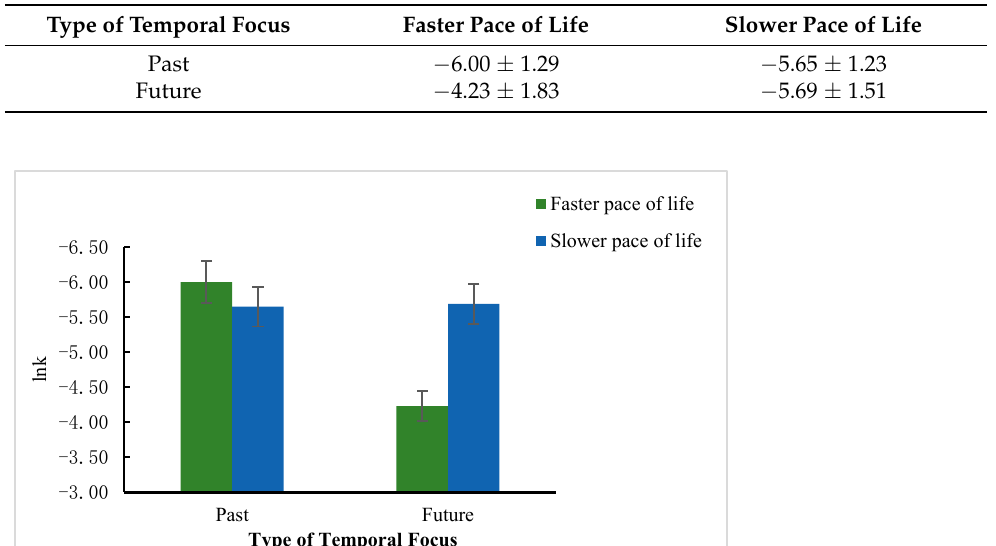
Table 4. Intertemporal decision scores (lnK) for participants with fast and slow paces of life in different temporal focus conditions ( M ± SD ).